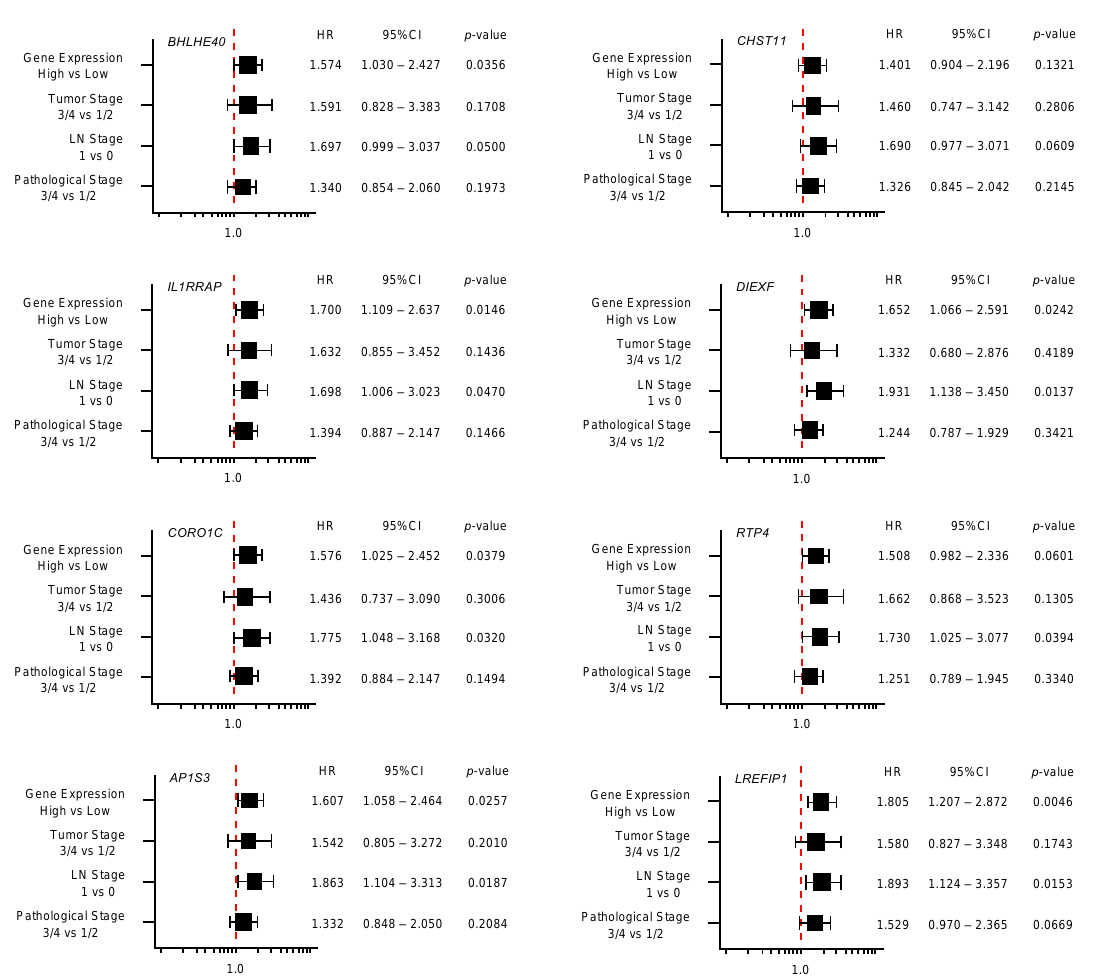
Figure 5. Forest plot of multivariate analysis of 18 target genes (that predicted 5-year survival) of miR-30c. The multivariate analysis determined that the expression levels of 10 genes ( YWHAZ , F3 , TMOD3 , NFE2L3 , ENDOD1 , ITGA3 , RRAS , PRSS23 , TOP2A , and LRRFIP1 ) were independent prognostic factors for 5-year overall survival after the adjustment for tumor stage, lymph node metastasis, and pathological stage ( p < 0.01).